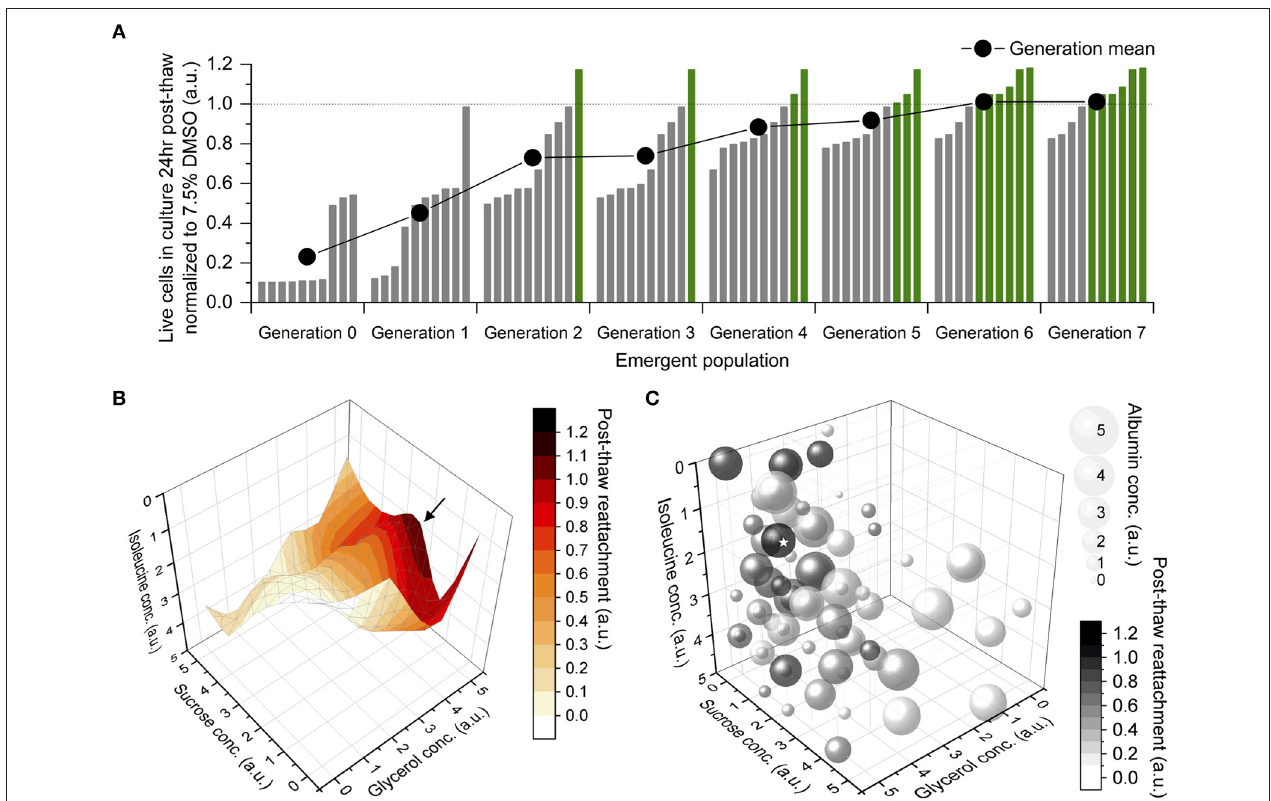
FIGURE 2 | Results of differential evolution (DE) algorithm-driven optimization. Sample size of 1 for accelerated optimization. (A) Emergent population of formulations of freezing solution improving then stabilizing in terms of their post-thaw reattachment normalized to a 7.5% dimethyl sulfoxide (DMSO) solution, at the end of which, 6 DMSO-free solutions were better than the DMSO control. (B) Topology of parameter space that the DE algorithm navigated through during optimization, shown in four of five dimensions. An optimum ( → ) was located toward medium concentration of sucrose, high concentration of glycerol and low concentration of isoleucine. (C) Bubble chart of all formulations tested by the DE algorithm, shown in all five dimensions. Bubble size correlated to albumin concentration. Grayscale intensity correlated to post-thaw cell reattachment. The optimum ( ⋆ ) located at level-2 sucrose, level-5 glycerol, level-1 isoleucine, level-4